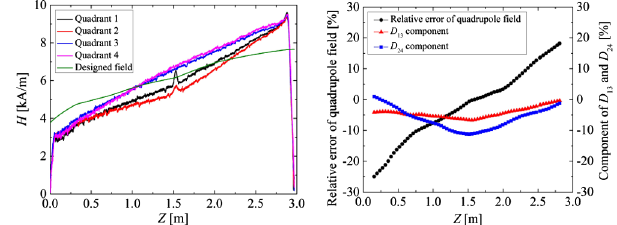
19. Field distribution in the four quadrants (left), relative error of the quadrupole field, and dipole component (right) before tuning.